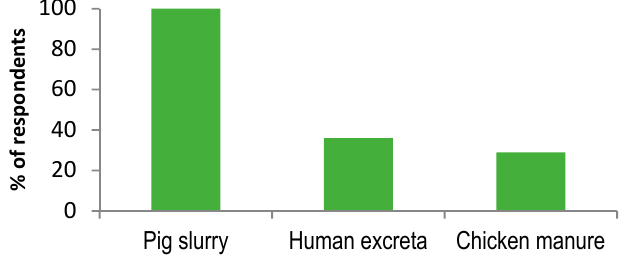
Figure 3. Feedstock used for biogas production (Multiple choices were possible) ( n = 107).